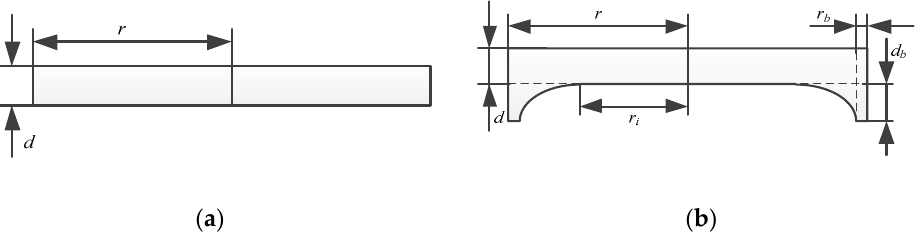
Figure 22. Structure of the proposed shield.